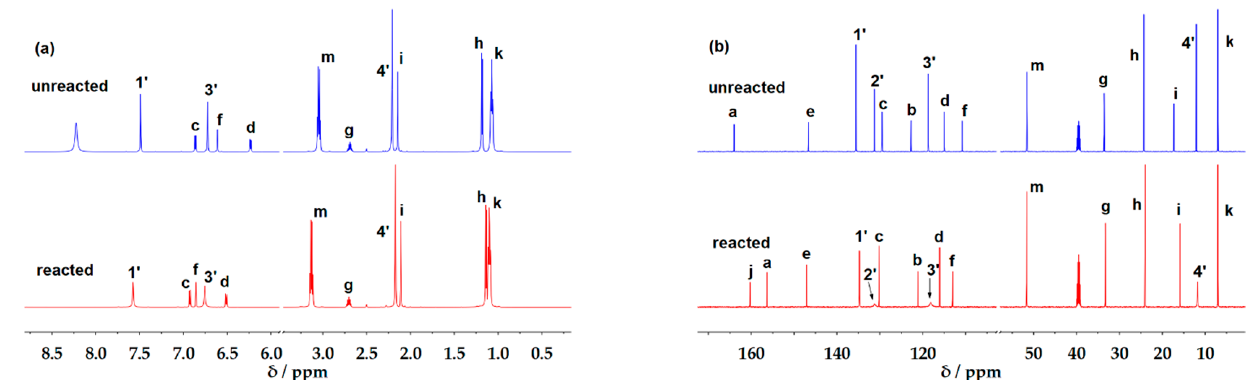
Figure 5. The 1 H ( a ) and 13 C ( b ) NMR spectra of [Et 4 N] [Car]:4CH 3 -Im (1:2) before and after CO 2 uptake. Letters from a to i are the labels of hydrogen or carbon atoms of [Car] anion with and without CO 2 . Letters m and k are the labels of hydrogen or carbon atoms of [Et 4 N] cation. Letter j is the label of carbonyl carbon of Car-based carbonate. Numbers 1’, 2’, 3’ and 4’ are the labels of hydrogen or carbon atoms of 4CH 3 -Im.